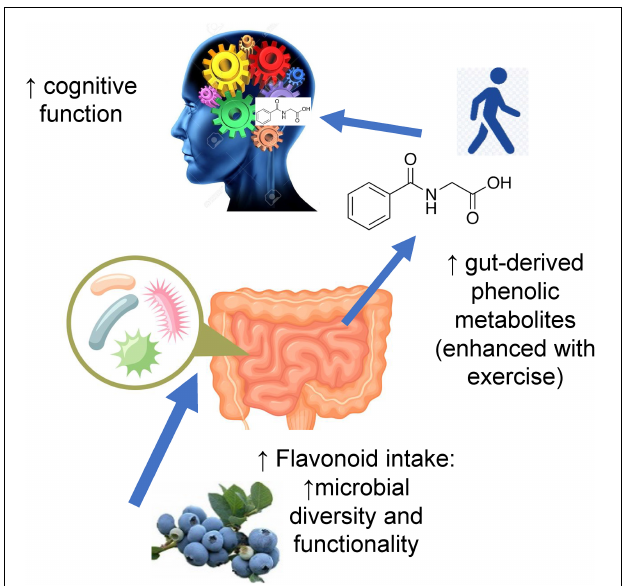
FIGURE 4 | Higher flavonoid intake may influence cognitive function by augmenting gut microbial diversity and functionality and increasing circulating levels of gut-derived phenolic metabolites. Moderate-to-vigorous physical activity (MVPA) adds to this effect by enhancing the release of gut-derived metabolites and improving cognitive